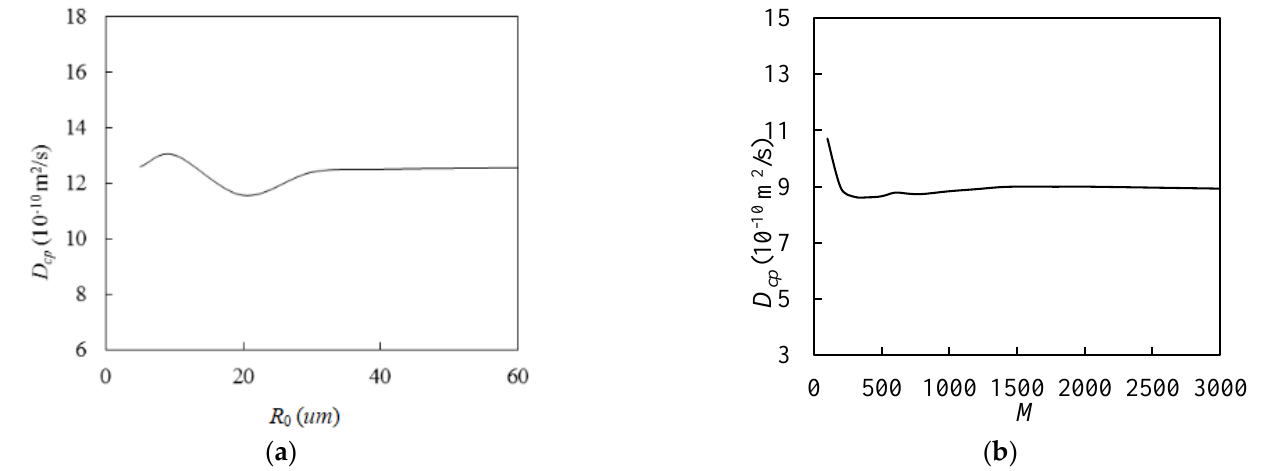
Figure 8. Effect of R 0 and M on the chloride diffusivity of cement paste: ( a ) effect of R 0 ; ( b ) effect of M .